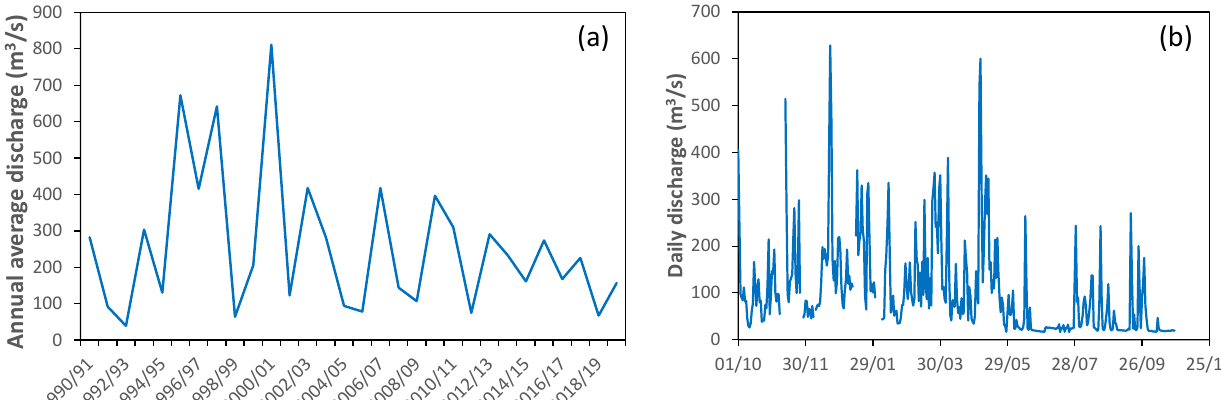
Figure 2. Data from Almourol hydrometric station (17G/02H), which was located just upstream of the studied river segment: ( a ) annual discharge time series for the period 1990/91–2019/2020; ( b ) daily discharge time series, for the period 1 October 2021–25 October 2022. A period of exceptional low river discharge occurred in the summer of